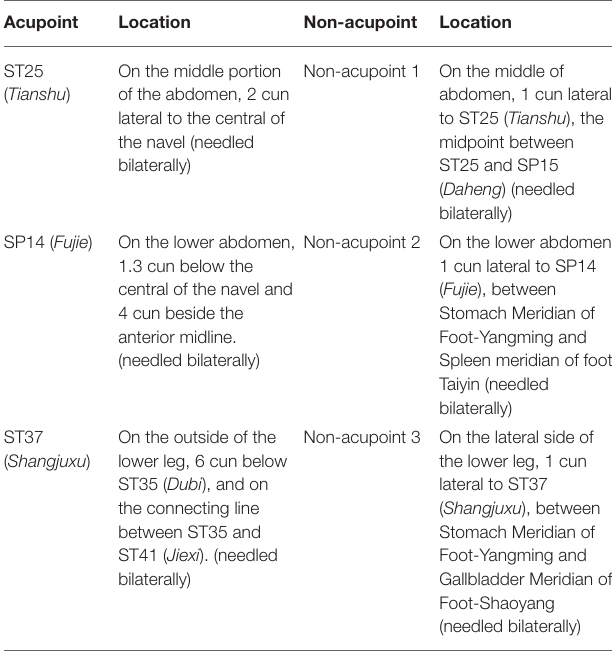
TABLE 2 | Acupoints and non-acupoints used in the acupuncture